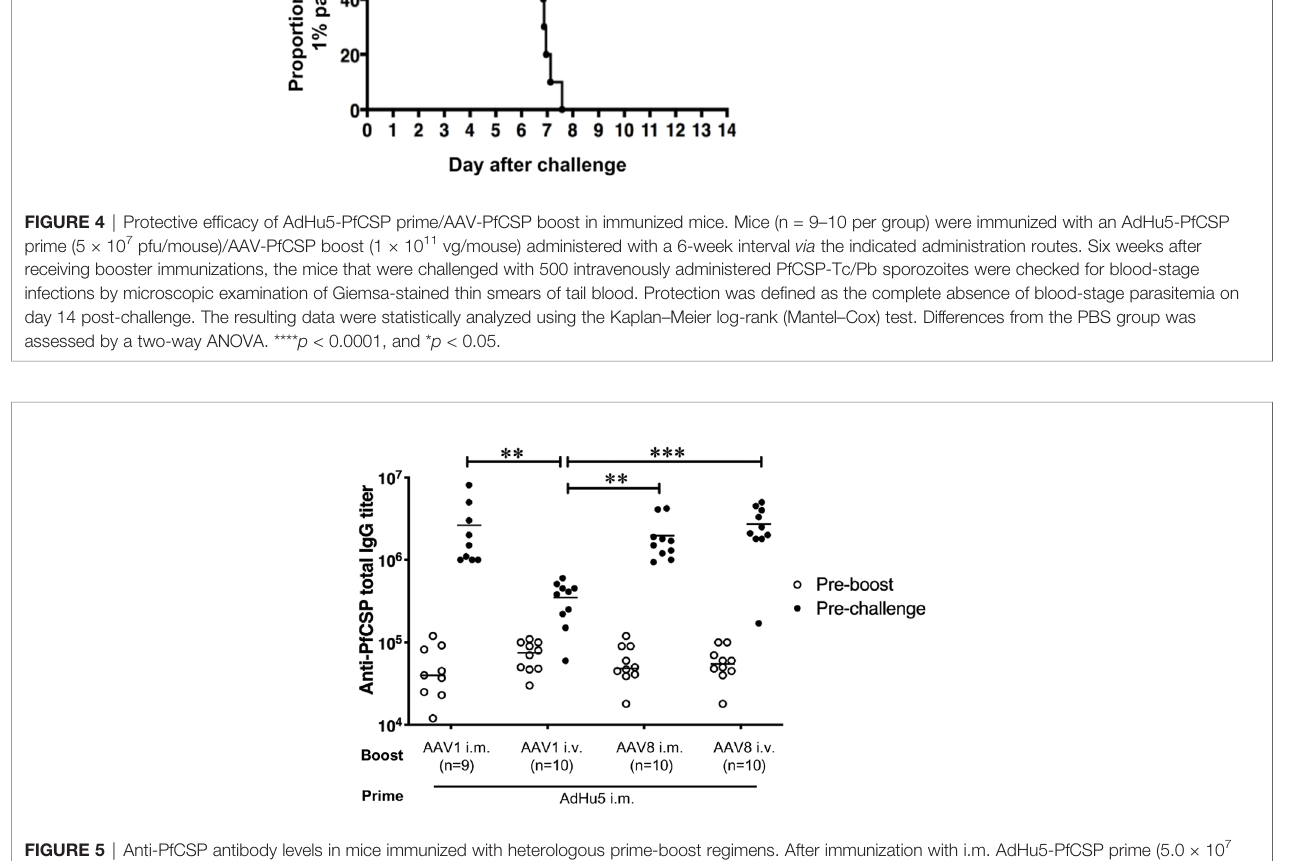
FIGURE 5 | Anti-PfCSP antibody levels in mice immunized with heterologous prime-boost regimens. After immunization with i.m. AdHu5-PfCSP prime (5.0 × 10 7 pfu/mouse)/AAV-PfCSP boost (1.0 × 10 11 vg/mouse), mice were challenged with 500 PfCSP-Tc/Pb sporozoites. Sera were collected one day before the boost and before the sporozoite challenge from the mice used in the challenge study. Anti-PfCSP antibody titers were determined by ELISA. Bars and error bars indicate the means and SDs of the values, respectively. Between-group differences were assessed with the Kruskal – Wallis test and Dunn ’ s correction for multiple comparisons. *** p < 0.001 and ** p <